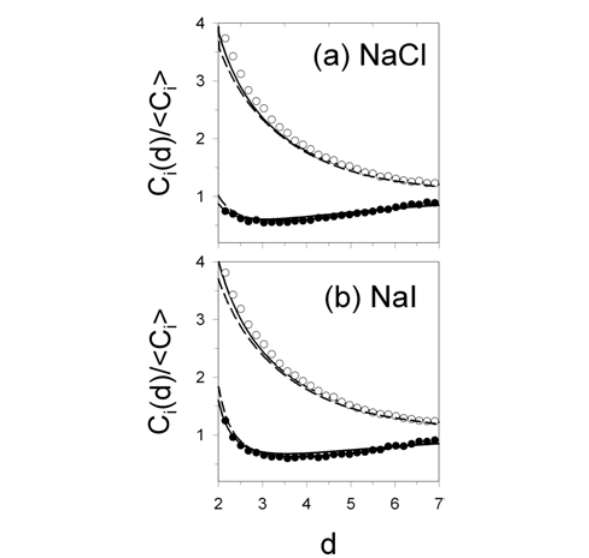
Fig. 3 – Concentration profiles near a macroion ( σ M = 30Å and − 20e 0 ) in a monovalent electrolyte solution of ionic strength 1.0 M for NaCl (a) and NaI (b). Open circles represent counterion concentrations, and dark circles the coions. Solid lines are numerical solutions of the non-linear Poisson-Boltzmann equation and dashed lines are for the OZ-HNC integral equation (Boström et al.